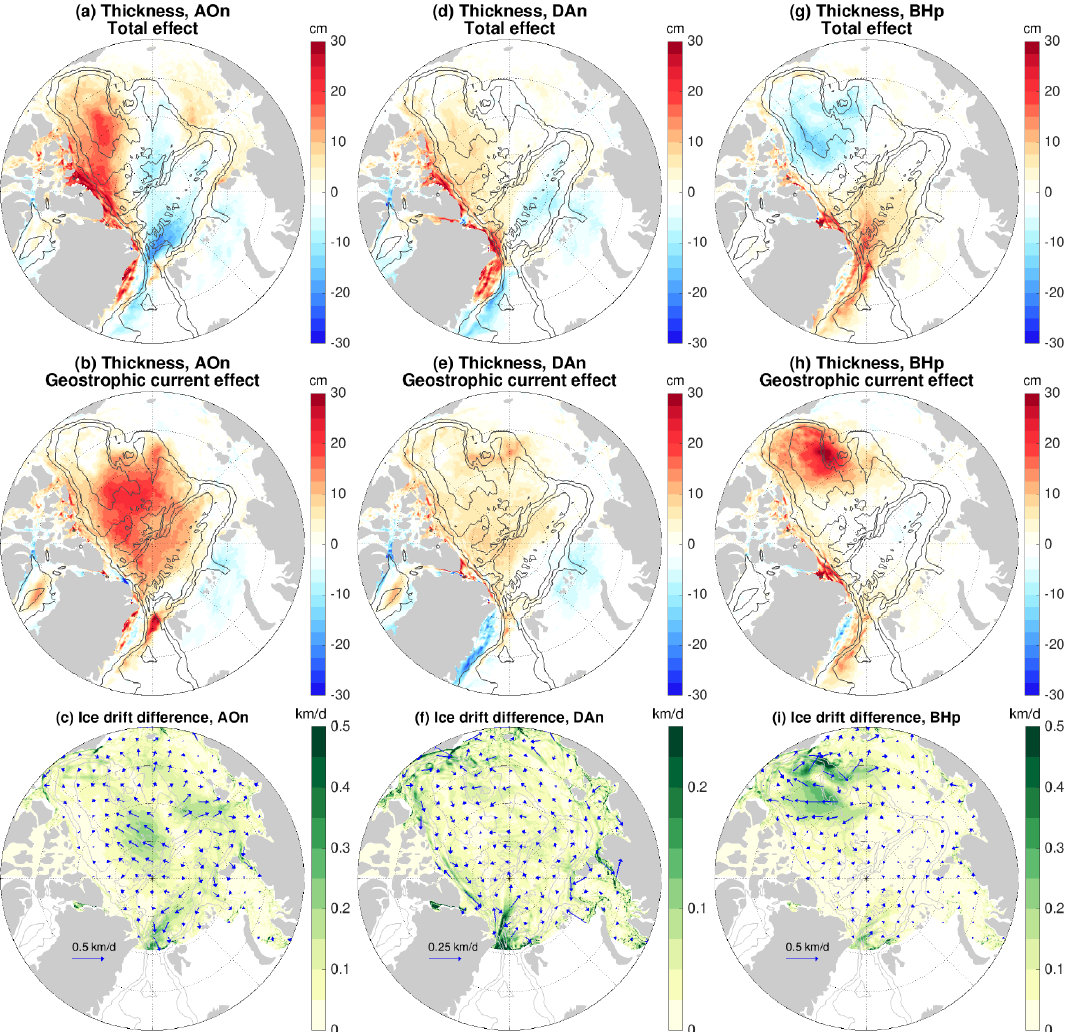
Figure 11. (a) Total anomaly of sea ice thickness in the sensitivity experiment with the initial ocean perturbed by applying the negative phase of Arctic Oscillation (AO) perturbation beforehand. The anomaly is referenced to the control run and averaged over the 4 years of the sensitivity experiment. (b) The same as (a) , but for the experiment with the sea surface height gradient force in the sea ice momentum equation taken from the control run, so the result indicates the impact of ocean surface geostrophic current through influencing ocean–ice stress. (c) The difference of sea ice drift between the two experiments associated with (a) and (b) . (d–f) The same as (a–c) , but for the experiments with the initial ocean spun up with the negative phase of Dipole Anomaly (DA) perturbation. (g–i) The same as (a–c) , but for the experiments with an initial ocean spun up with the positive phase of Beaufort High (BH) perturbation. Note that the scaling for velocity arrows and color patches in the DA case in (f) is different from other cases in (c) and (i) . The black contour lines indicate the 500, 2000 and 3500m